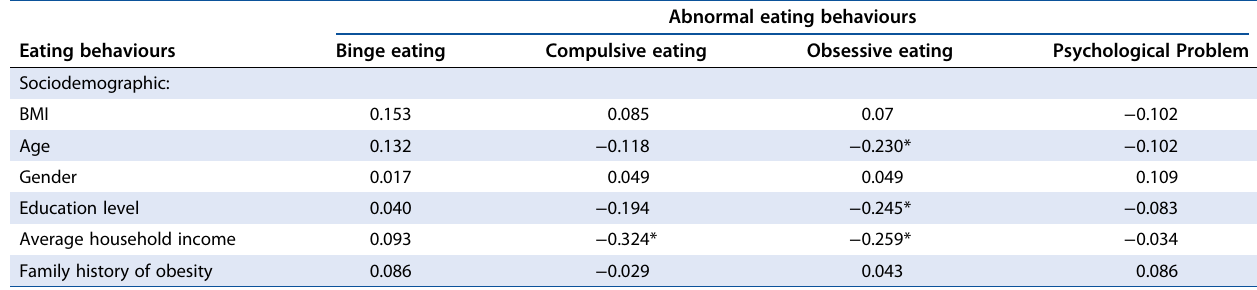
Abnormal eating behaviours